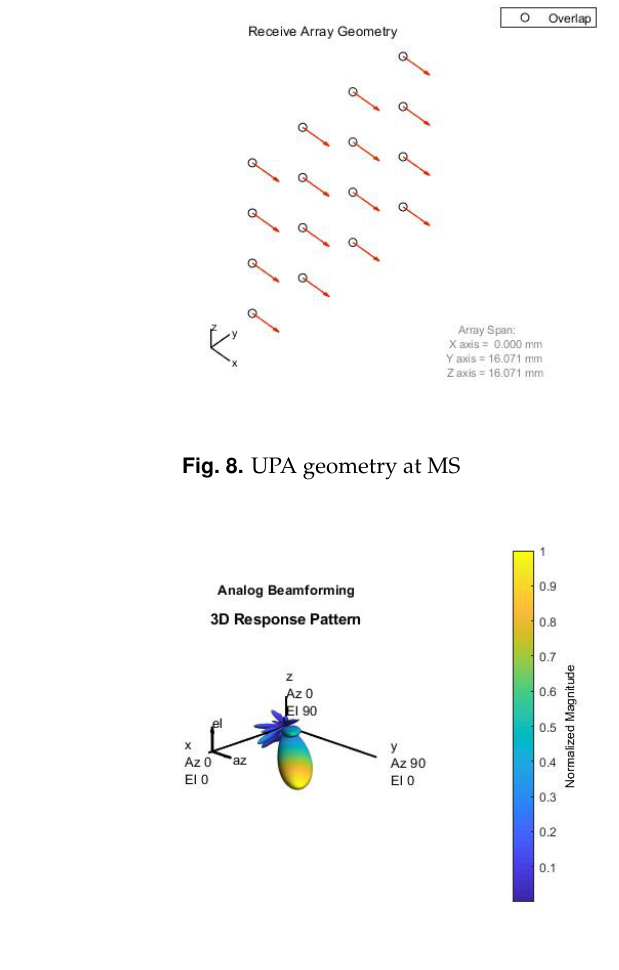
Fig. 9. Radiation response of